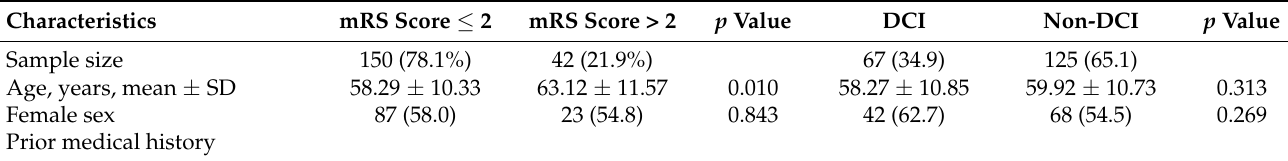
Table 2. Univariate analysis of baseline characteristics of mRS and